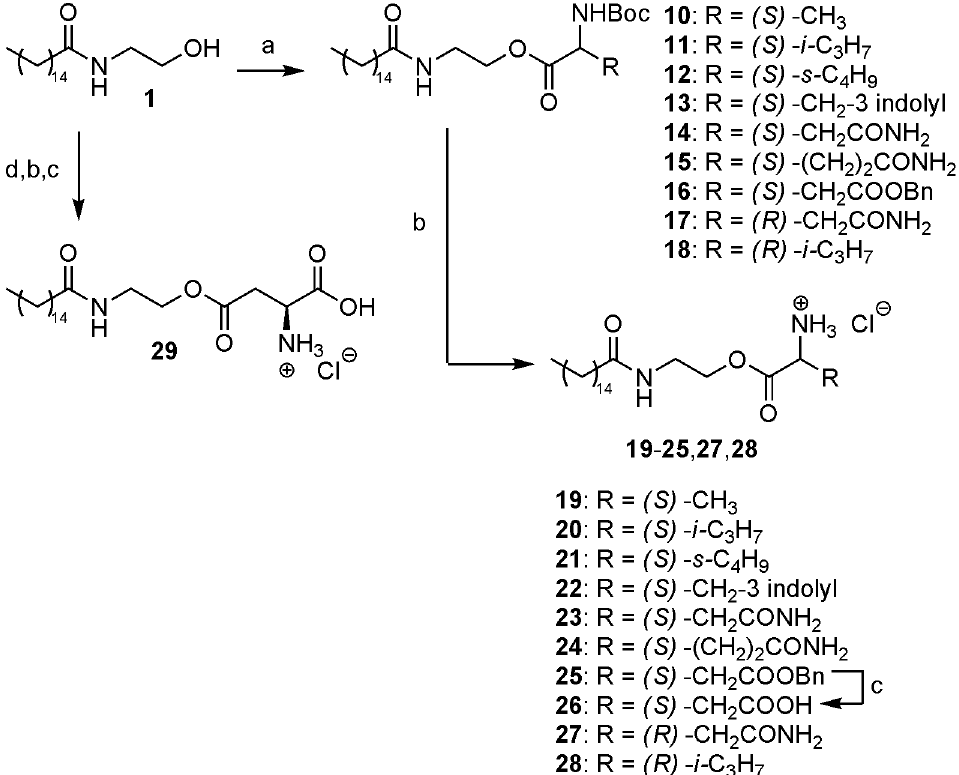
Fig 5. Synthesis of amino acid esters of PEA. Reagents and conditions: (a) RCH(NHBoc)COOH, DCC, DCM, 23°C, 12 h; (b) HCl, AcOEt, rt, or TFA/DCM 1:1 v/v, 0°C, 1 – 3 h, then HCl in AcOEt; (c) H 2 , Pd/C 10% w, HCl, EtOH, rt; (d) N -Boc-1- O -Bn-L- aspartic acid, DCC, DCM, 23°C, 12 h.